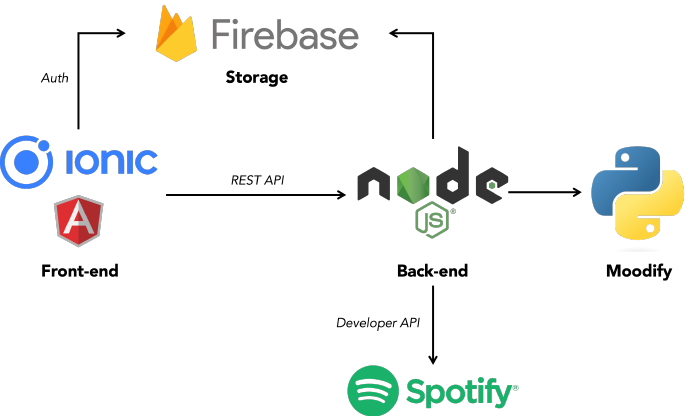
Figure A1. The architecture of MoodifyWeb. MoodifyWeb’s architecture is built using JavaScript and Python languages (see Figure A1). In particular, the front-end has been developed by means of the framework including Ionic JS (Available online: https://ionicframework.com/docs/, accessed on 18 October 2022) and Angular JS (Available online: https://angular.io/, accessed on 18 October 2022), it performs the authentication of users on the Firebase (Available online: https://firebase.google.com/, accessed on 18 October 2022) storage, and calls for server utilities through REST APIs. In the back-end, we employed Node JS (Available online: https://nodejs.org/it/, accessed on 18 October 2022) that sends data to the RL-based music recommender written in Python ( Moodify approach) and waits for its output and search for music tracks on Spotify via the developer API. The Python module also stores the serialized version of the personal Moodify for each